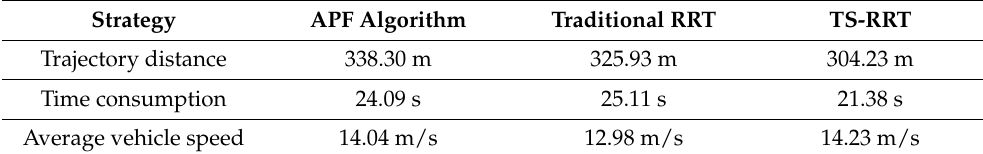
Table 2. Comparison of results (average value of 10 times).